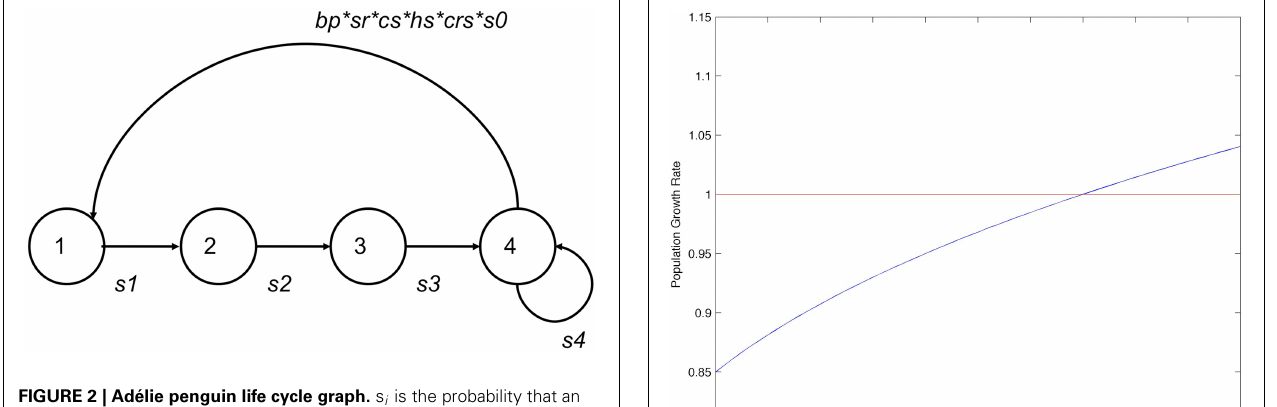
FIGURE 2 | Adélie penguin life cycle graph. s i is the probability that an individual in stage i survives from time t to time t + 1; bp is the probability, conditional on survival, that an individual in stage i breeds; sr is the assumed sex-ratio at birth; cs is clutch size; hs is the probability of an egg to hatch; crs is the probability of a chick to survive until the crèche stage. The graph corresponds to the matrix population model (Equation 1) (see Methods section).